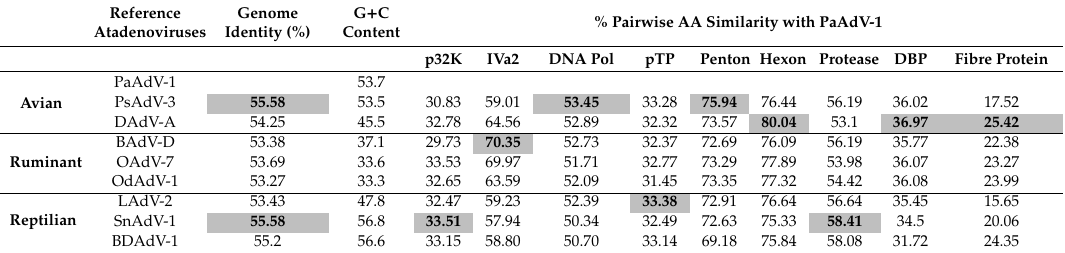
Table 2. Comparative G + C (%) content and pairwise identity of representative atadenovirus species against passerine adenovirus 1 (PaAdV-1) on the basis of complete genome nucleotide sequences and selected core proteins amino acid sequences. Shading and bold front highlights maximum similarity. Selected proteins were aligned by using MAFFT in Geneious (version 10.2.2, Biomatters, Ltd., Auckland, New Zealand) with the chosen of following parameters to calculate % similarity: scoring matrix BLOSUM62, Gap open penalty = 1.53. Blosum62 with threshold 1 (percentage of residues which have score > = 1 in the Blosum62